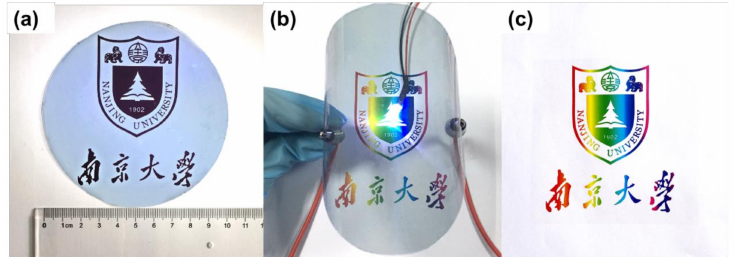
Figure 8. Photographs of the fabricated Au nanomesh film sample, indicating its ( a ) transparent and uniform over a large area and ( b ) excellent flexibility and electrical conductivity properties. ( c ) Photograph of the iridescent logo in ( b ) without the Au nanomesh film as a comparison.